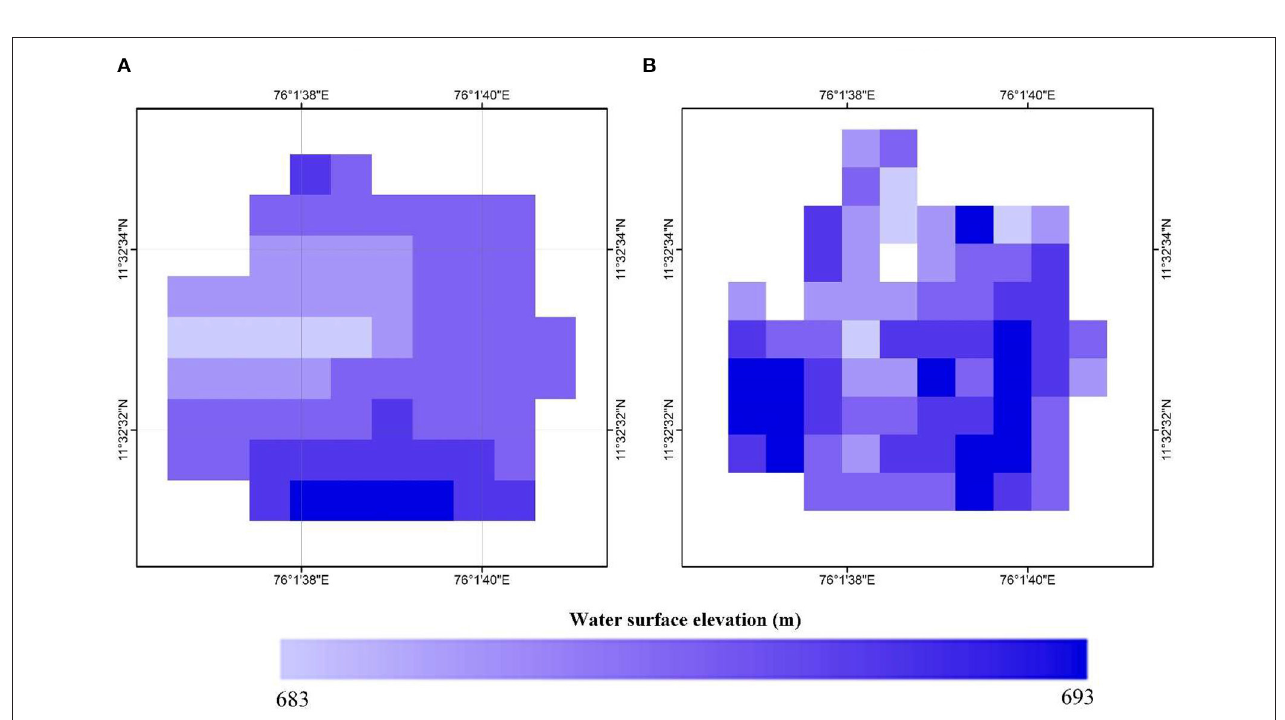
FIGURE 6 | Variation in water level in Pookode Lake extracted using interferometric SAR before and after flood in (A) 2015 and (B)